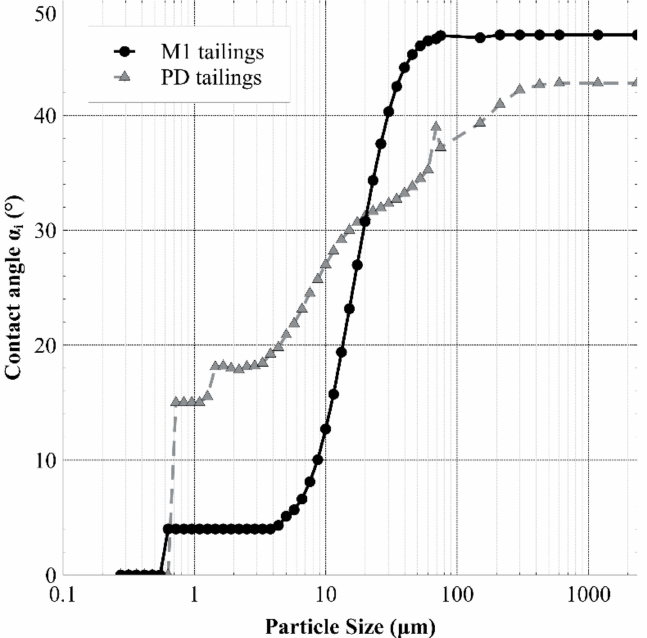
Figure A2. Contact angles calculated for each particle size bin ( α i ) of M1 and PD tailings, as determined by Equation